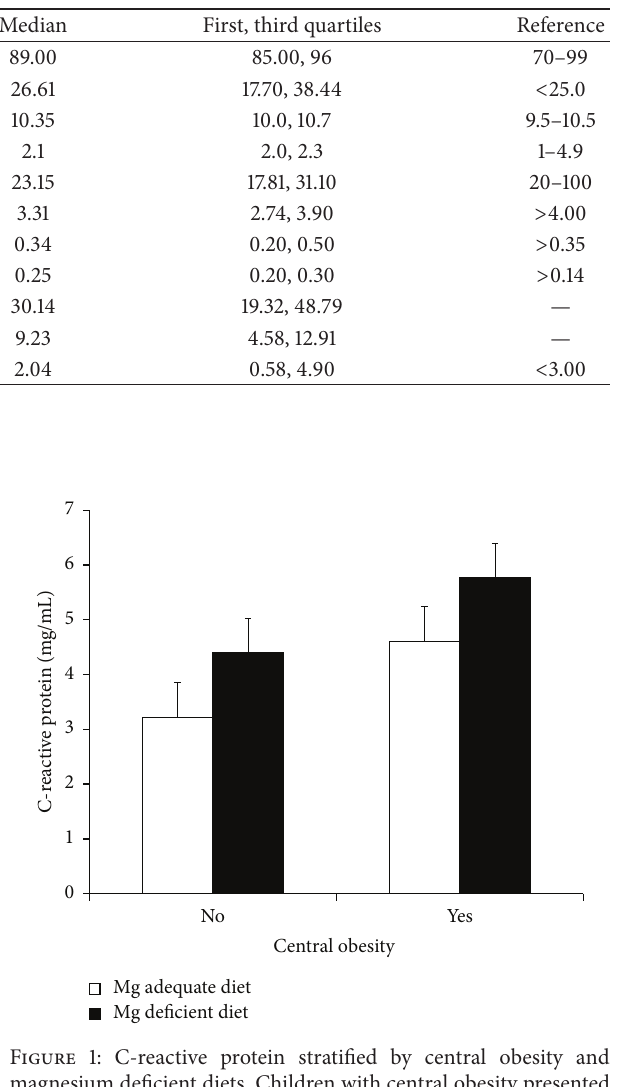
Table 2: Circulating factors as compared to references 1 .